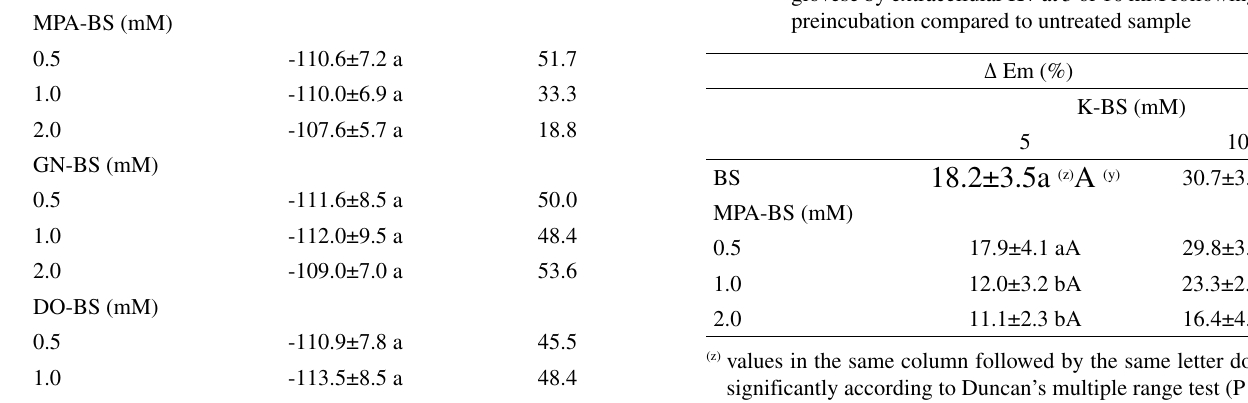
Table 3 - Depolarization induced in samples of Vitis vinifera cv. San- giovese by extracellular K+ at 5 or 10 mM following